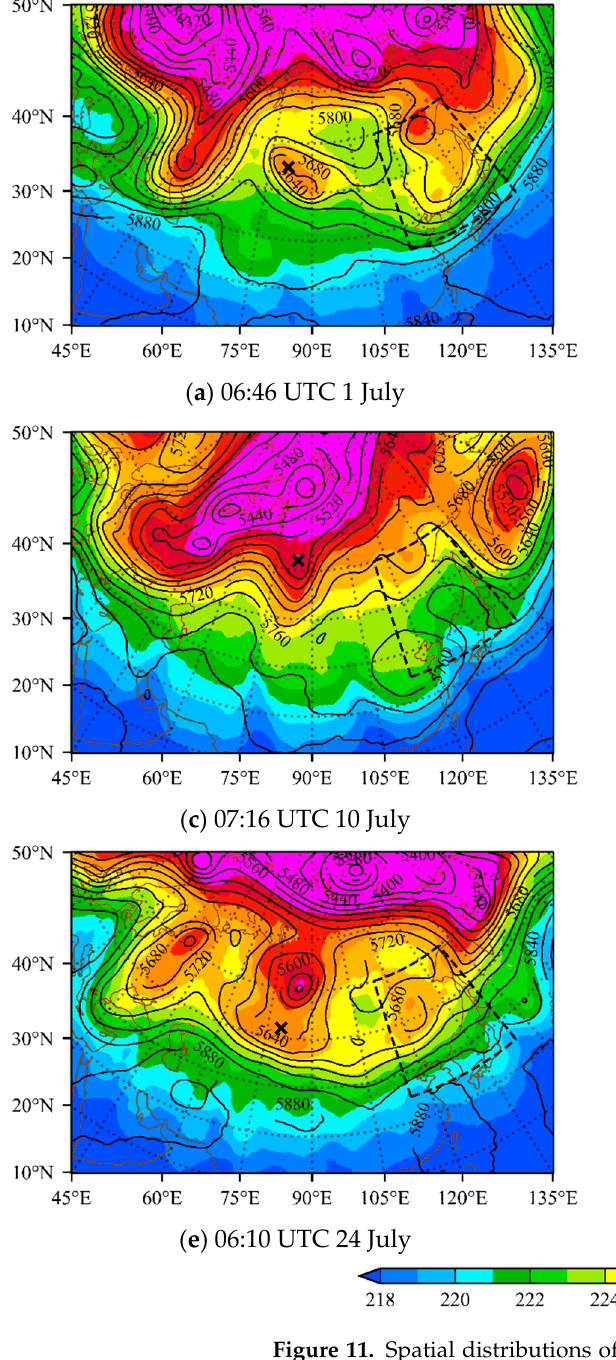
Figure 11. Spatial distributions of MWTS-2 channel 7 limb-corrected brightness temperature observations (color shaded, unit: K) at (left panels) case starting time and (right panels) the time of cutoff low center entering the NCCV domain of three cases in July 2019, with geopotential height at 500 hPa of ERA5 reanalysis (contours, interval: 40 gpm). The black crosses indicate the NCCV centers determined by high brightness temperature center of channel 7.